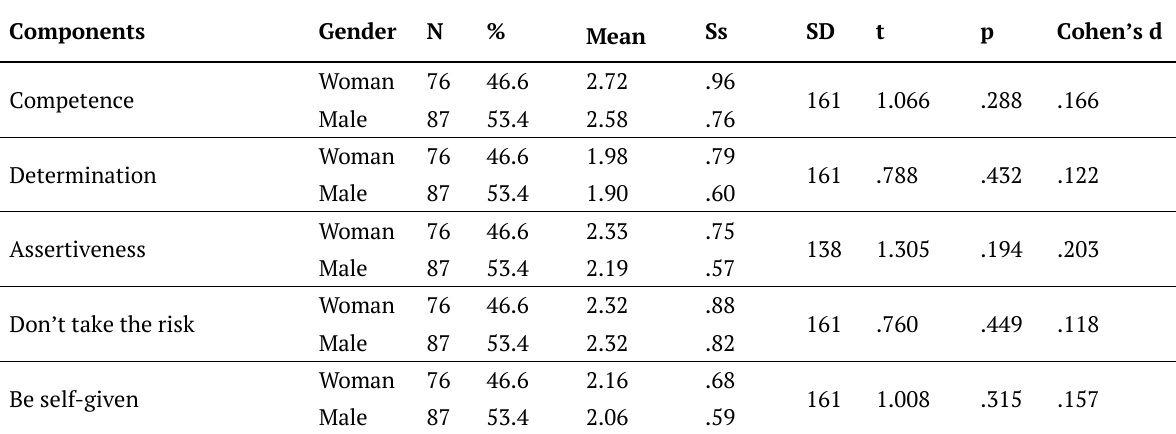
Table 1. T-test results for the sub-dimensions of courage in sports by gender variable N=163 Components